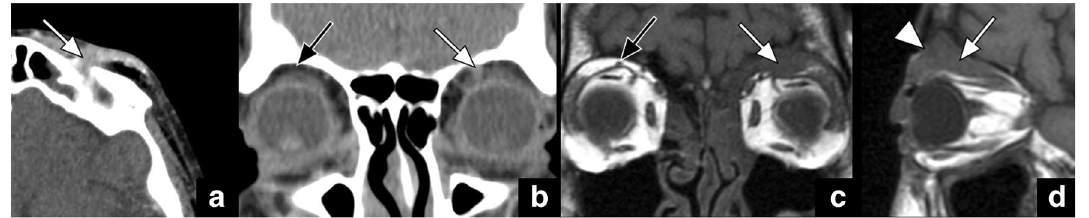
Fig. 2 Axial CT ( a ) and coronal reformatted CT ( b ) images show obliteration of the fat pad anterior to the superior orbital rim ( arrow in a ) and superior to the levator palpabrae muscle ( white arrow in b ) when compared to its normal appearance ( black arrow in b ). The coronal ( c ) and sagittal ( d ) T1 weighted images in a different patient reveal obliteration of the fat pad superior to the left levator palpebrae muscle